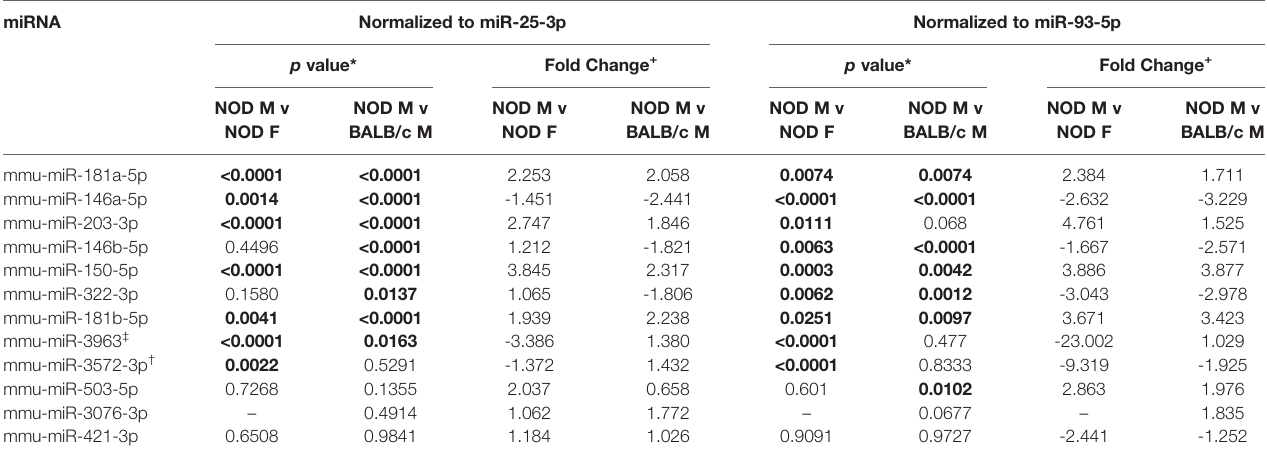
TABLE 2 | qPCR validation of differentially expressed miRNA in male NOD mice tears. miRNA Normalized to